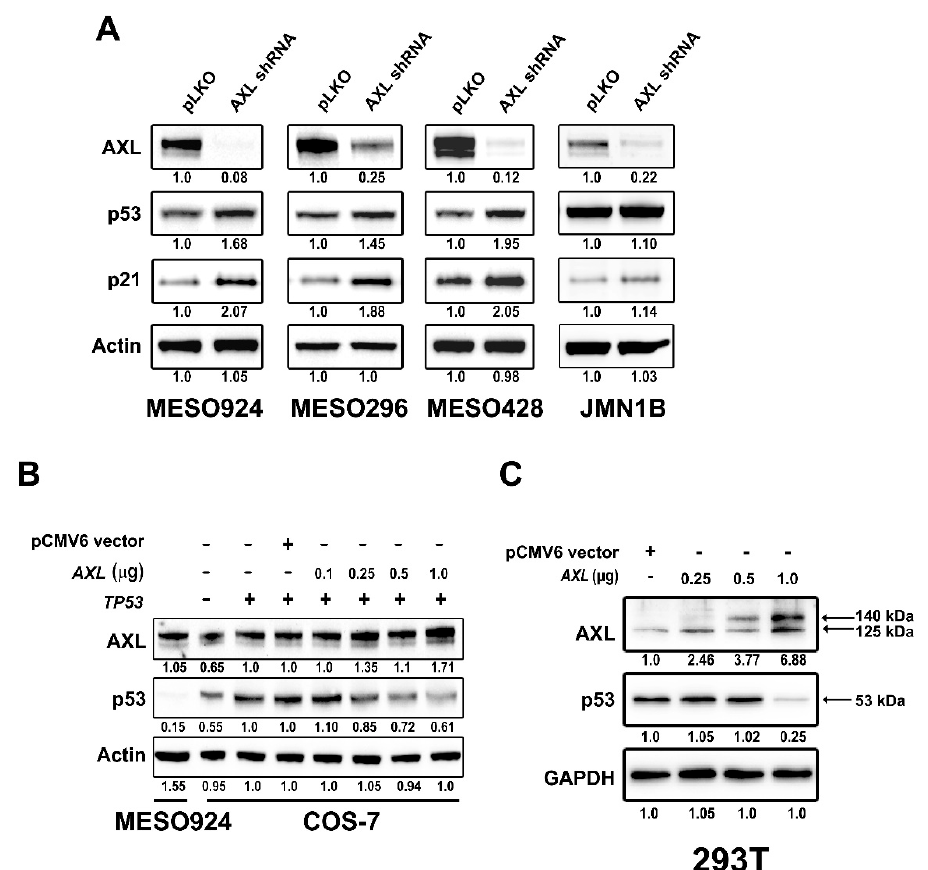
Figure 2. AXL regulates p53 protein expression. ( A ) Immunoblotting evaluation of the expression of AXL, p53, and p21 in MESO924, MESO296, MESO428, and JMN1B cells at 96 h post-infection with lentiviral AXL shRNA. Actin stains show equivalence of lane loading. Expression quantitations of AXL, p53, p21, and actin are normalized to control infections using empty vector pLKO. ( B ) Immunoblotting shows dose-dependent AXL inhibition of p53 expression in COS-7 cells 48 h after cotransfection of TP53 (1 µg) with varying amounts of AXL . pCMV6 (1 µg) vector lane is a control, and MESO924 is a positive control for AXL expression. Protein expression quantitations are normalized to control transfections using empty vector pCMV6. ( C ) Immunoblotting shows dose-dependent AXL inhibition of p53 expression in 293T cells 48 h after transfection with varying amounts of AXL . pCMV6 (1 µg) vector lane is a control. GAPDH stain is a loading control. Expression quantitations of AXL and p53 are normalized to control transfections using empty vector pCMV6. The whole blot (uncropped blots) show in the Figure